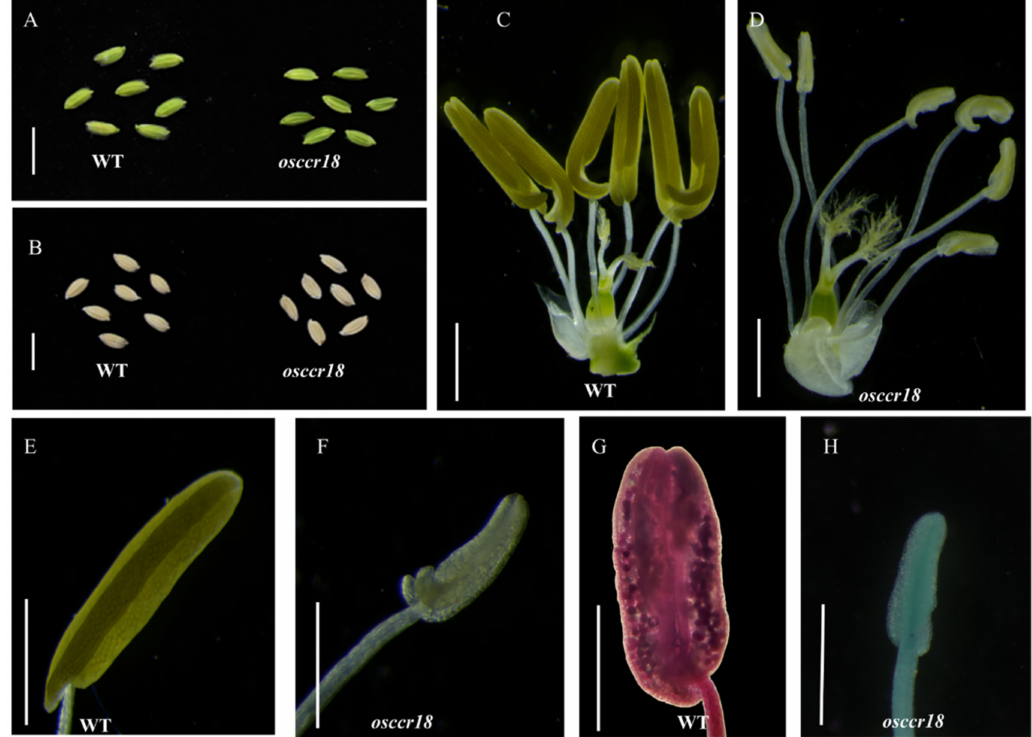
Figure 3. Phenotypic analysis of WT and osccr18 mutants. ( A , B ) Comparison of the spikelet morphology of WT and mutants at the grain filling ( A ) and maturity stages ( B ). ( C – F ) Comparison of the anther morphology of WT and mutants at the flowering stage. ( G , H ) Alexander staining of pollen of WT and mutants at the flowering stage.